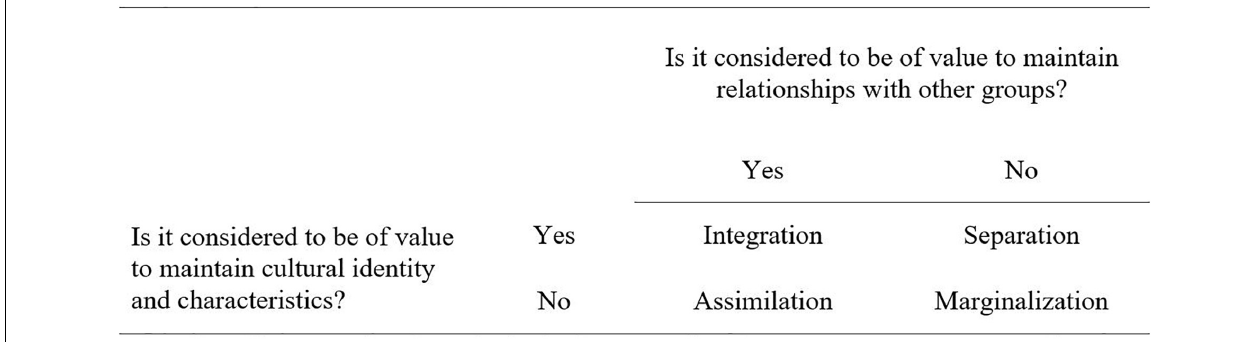
FIGURE 1 | Model of four acculturation strategies. Adapted from Berry